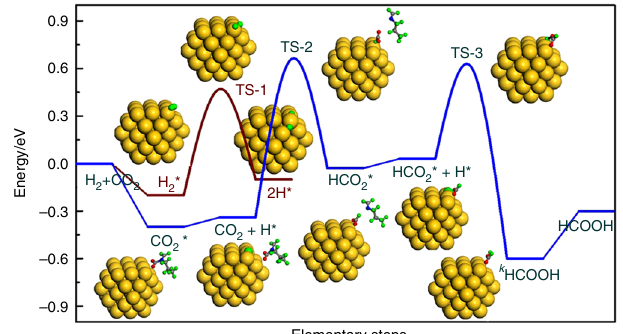
Fig. 4 Free energy diagram for CO 2 hydrogenation over the Au/SiO 2 -Schiff catalyst. The geometry with a close-packed Au 55 sub-nanocluster (~1.2 nm) accommodated with an alkyl-imine Schiff base under the COSMO solvent effect of water was used to model the real Au/SiO 2 -Schiff catalyst in water. Energy pro fi le was constructed based on the DFT calculation analysis of